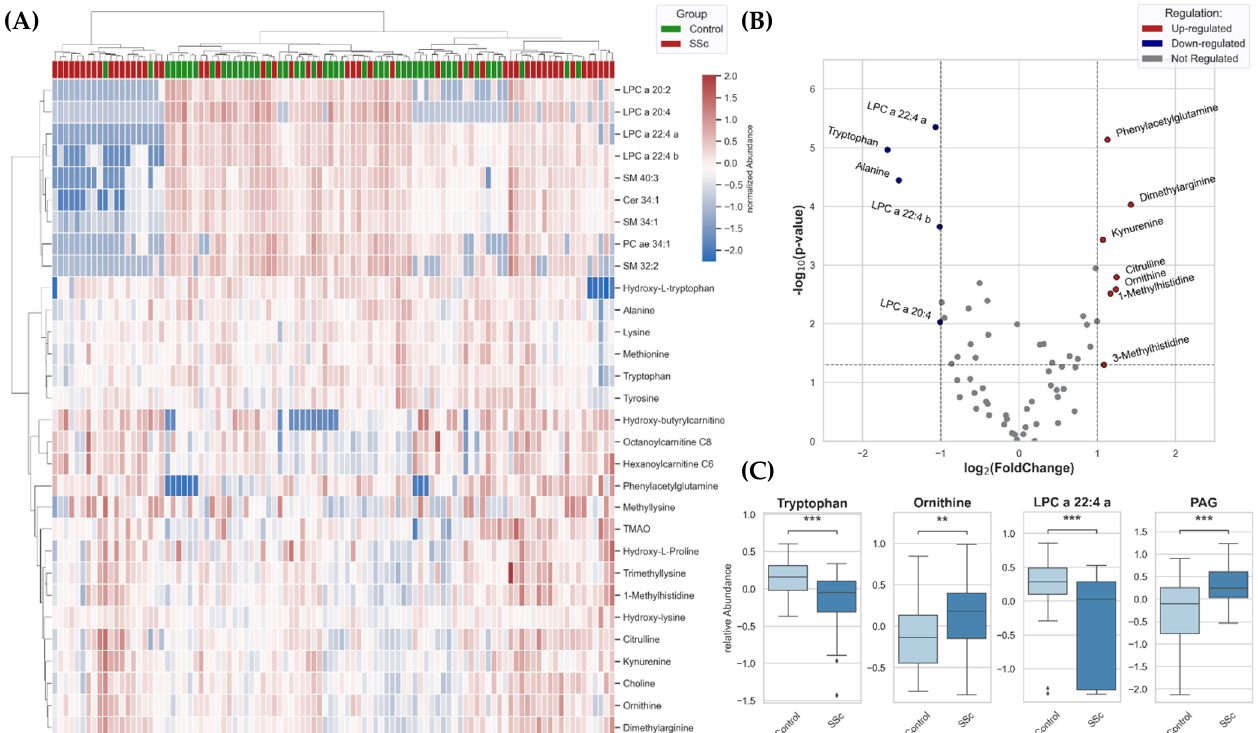
Figure 1. ( A ) Heatmap for all identified features from plasma of SSc patients ( n = 52) and controls ( n = 48) was generated based on a selection of the best 30 molecules due to t -tests using clustering method (Distance measure: Euclidean, Algorithm: Ward). ( B ) p -values and fold change were used for creating a two-dimensional volcano plot of summarized metabolites identified in metabolomics approaches. ( C ) Box Plots (Box = IQR, whiskers = 1.5 × IQR, horizontal bars = median) of significantly dysregulated metabolites. LPC = lysophosphatidylcholine, PAG = phenylacetylglutamine. p -values were determined using a two-tailed Student’s t -test; p < 0.05 was considered significant (** p < 0.01, *** p < 0.001).